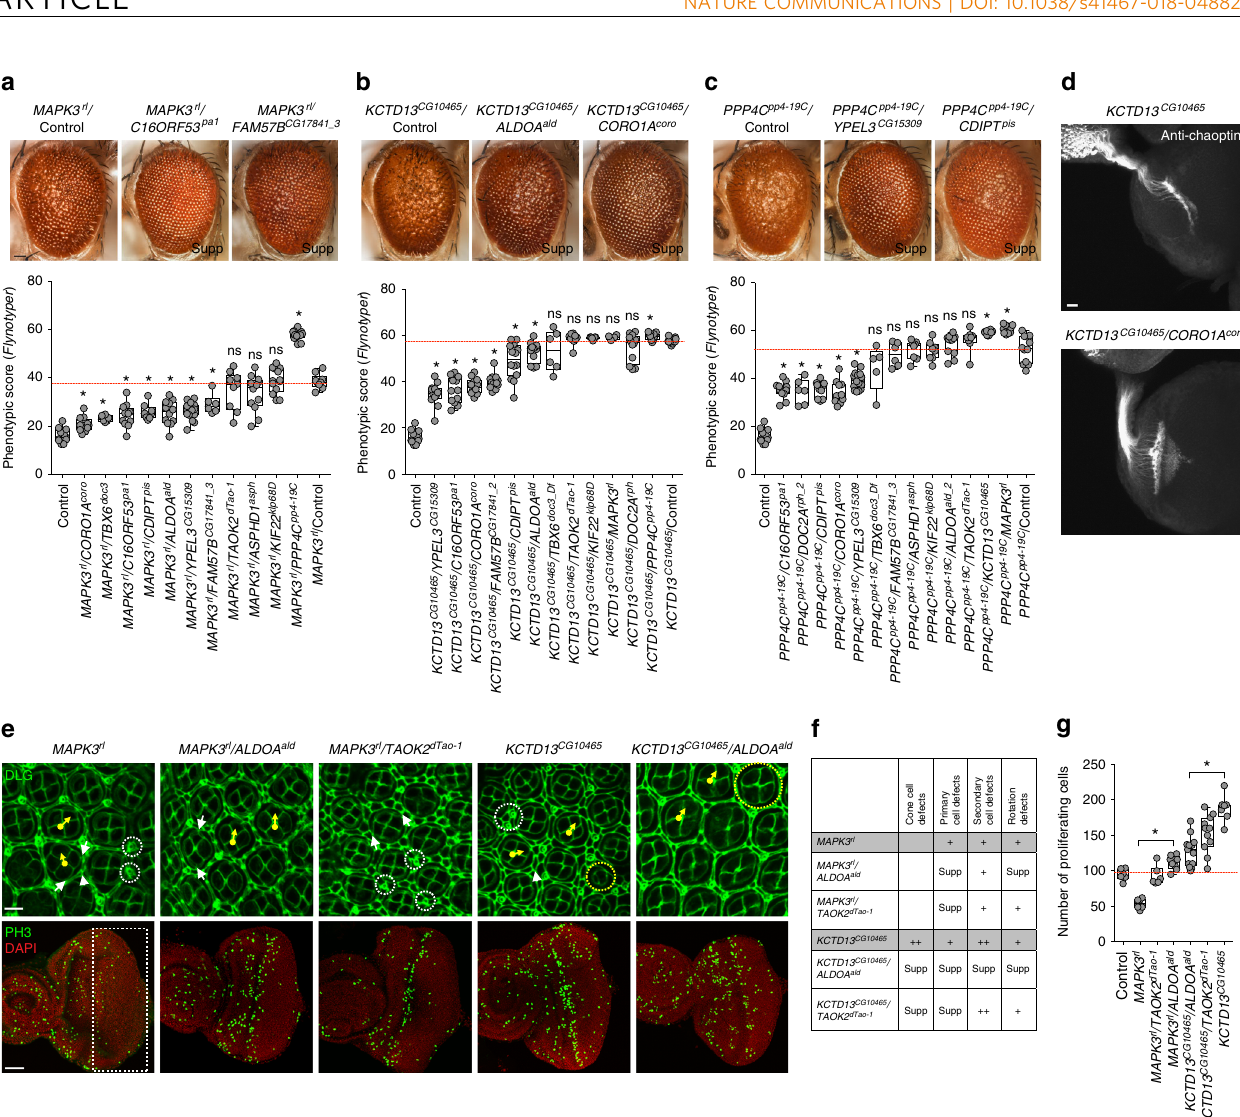
Mann – Whitney test). All boxplots indicate median (center line), 25th and 75th percentiles (bounds of box), and minimum and maximum